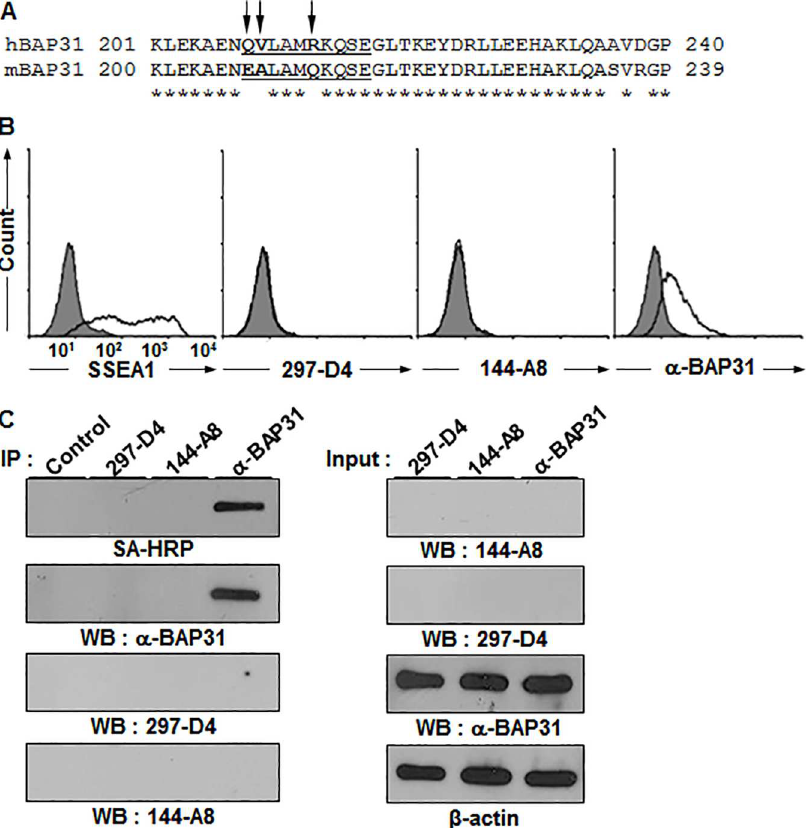
Fig 5. BAP31 is also expressedon the surface of mESCs. (A) The epitopesequencesof 297-D4 and 144-A8 are different betweenhESCs and mESCs. The partial C-terminal amino acid sequences were aligned betweenhumanand mouse BAP31. The epitopesequencesare underlined, and the different amino acids are indicatedby arrows. (B) Flow cytometry analysisof mESCs with anti-SSEA-1, 297-D4,144-A8, and α -BAP31 antibodies. (C) Immunoprecipitationof mESCs with 297-D4,144-A8, and α -BAP31antibodies.Cell surface proteinsof mESCs were biotinylated,immuoprecipitated, and analyzedby SA-HRP or western blot with α - BAP31 (left panels).The input samples were also analyzedby western blots (right panels). β -actin was used as a